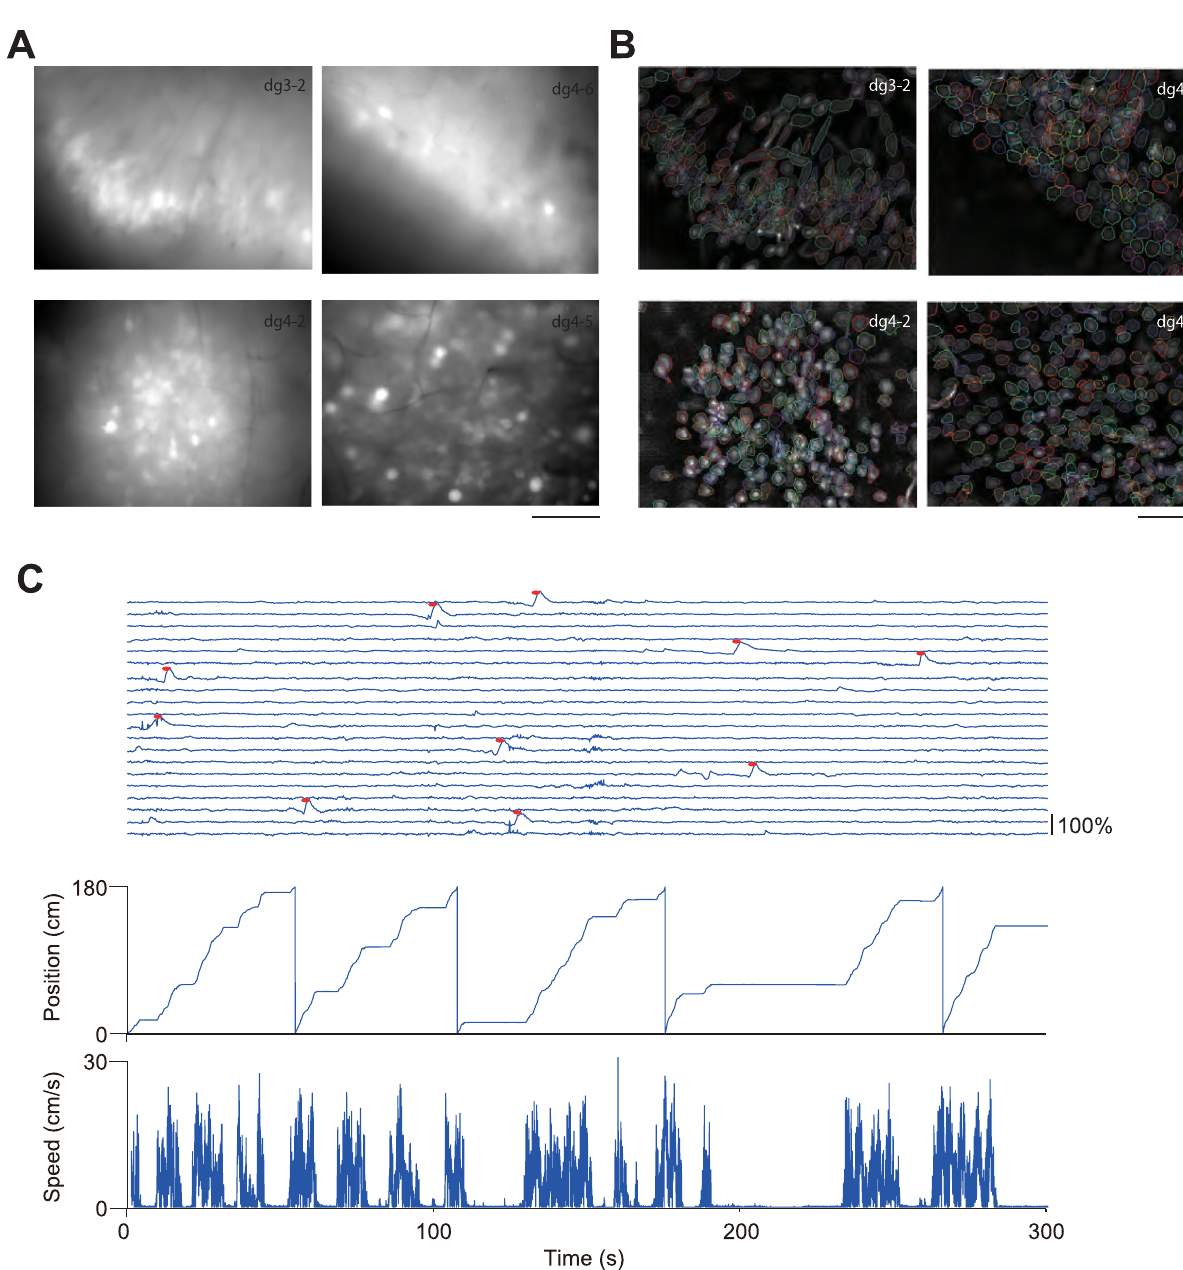
Fig 3. Imaging the dentate gyrus in behaving mice. (A) Averagedfluorescence images across entire recordingsession.Scale bar, 100 μ m. (B) Contoursof putative cell bodiesidentifiedwith a PCA and ICA-basedcell sorting algorithm(Cellsort1.0, Mukamel et al., 2009). Scale bar, 100 μ m. (C) Traces of dF/F calcium signal were shown. Identified calcium transients are shown as red dots. The position of the mouse along the virtual track is shown at the bottom. Animal position and speedin the virtual track was shown in the